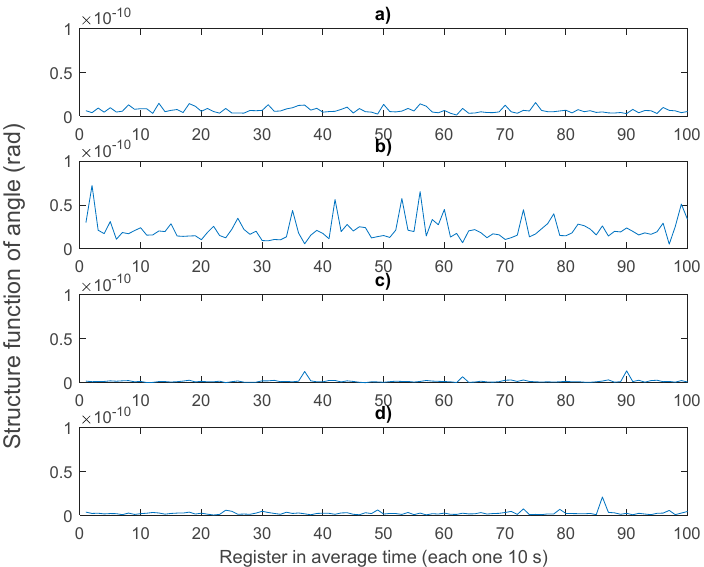
Figure 13. Fluctuations for the angle of centroid ( θ ) according to Test: ( a ) Pattern. ( b ) Test #1. ( c ) Test #2. ( d ) Test #3. Source: Authors. Table 4. Statistics of parameters to calculate θ and σ 2